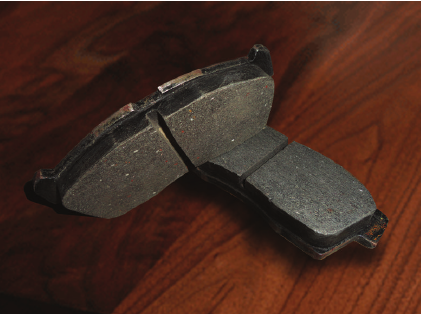
Figure 6: Finished brake pad.